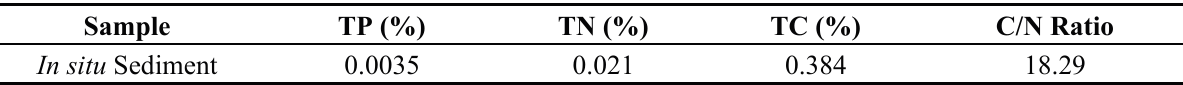
Table 1. The original organic matter content of the sediment. TP, total phosphorus; TN, total nitrogen; TC, total